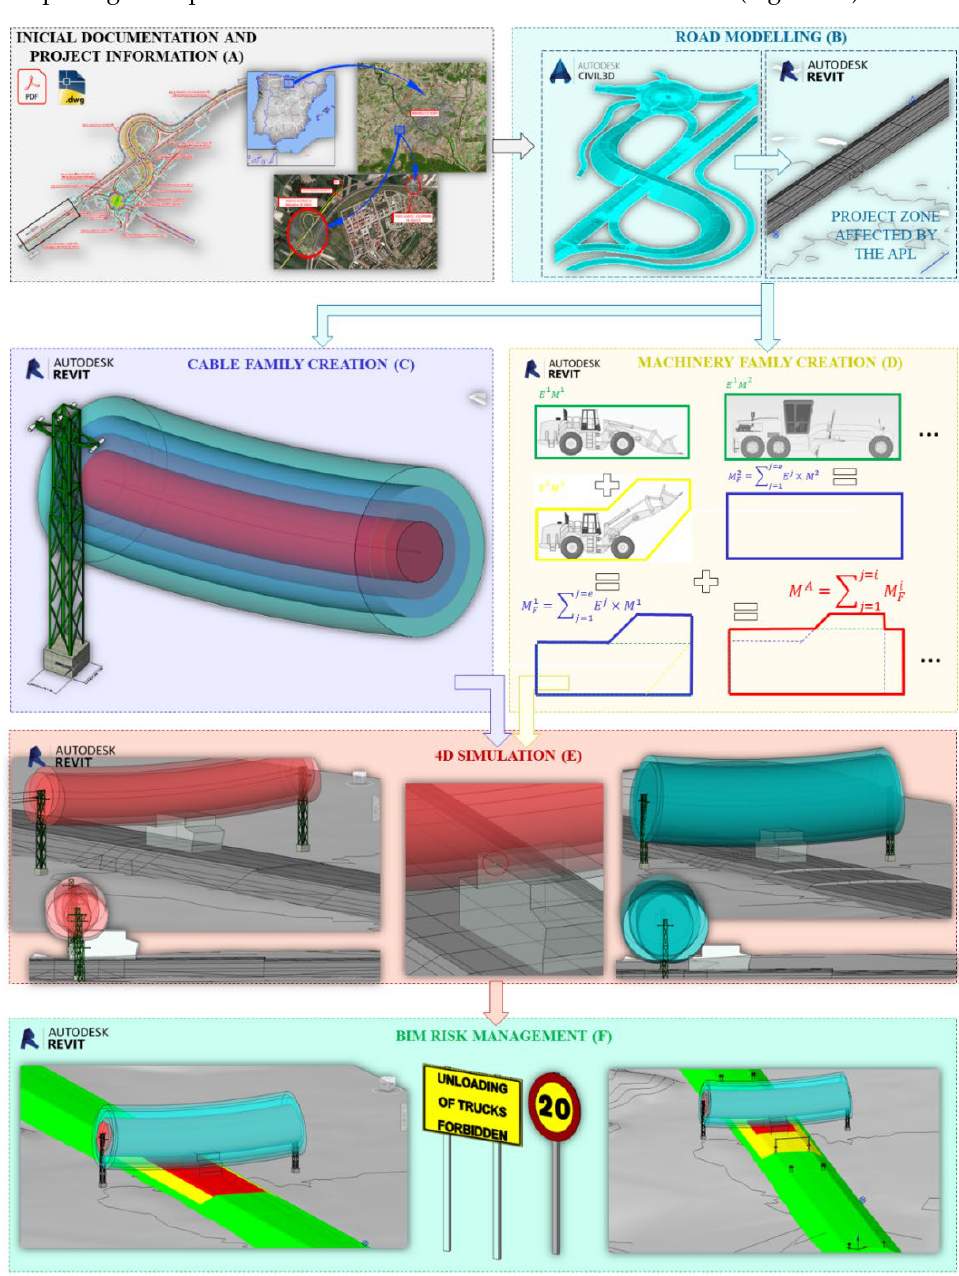
Figure 1. General outline of the methodology.